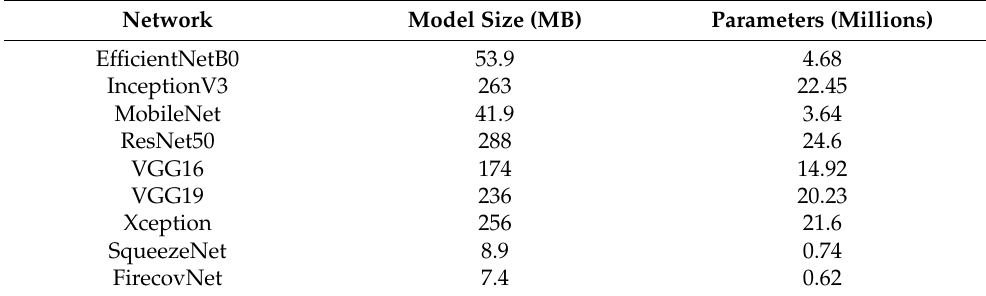
Figure 10. Comparison of different networks in terms of accuracy, precision, sensitivity, and F1-score in 5-class classification task. Table 7. Comparison of the number of parameters and size of the saved model for different networks in a 5 ‐ class classification task.